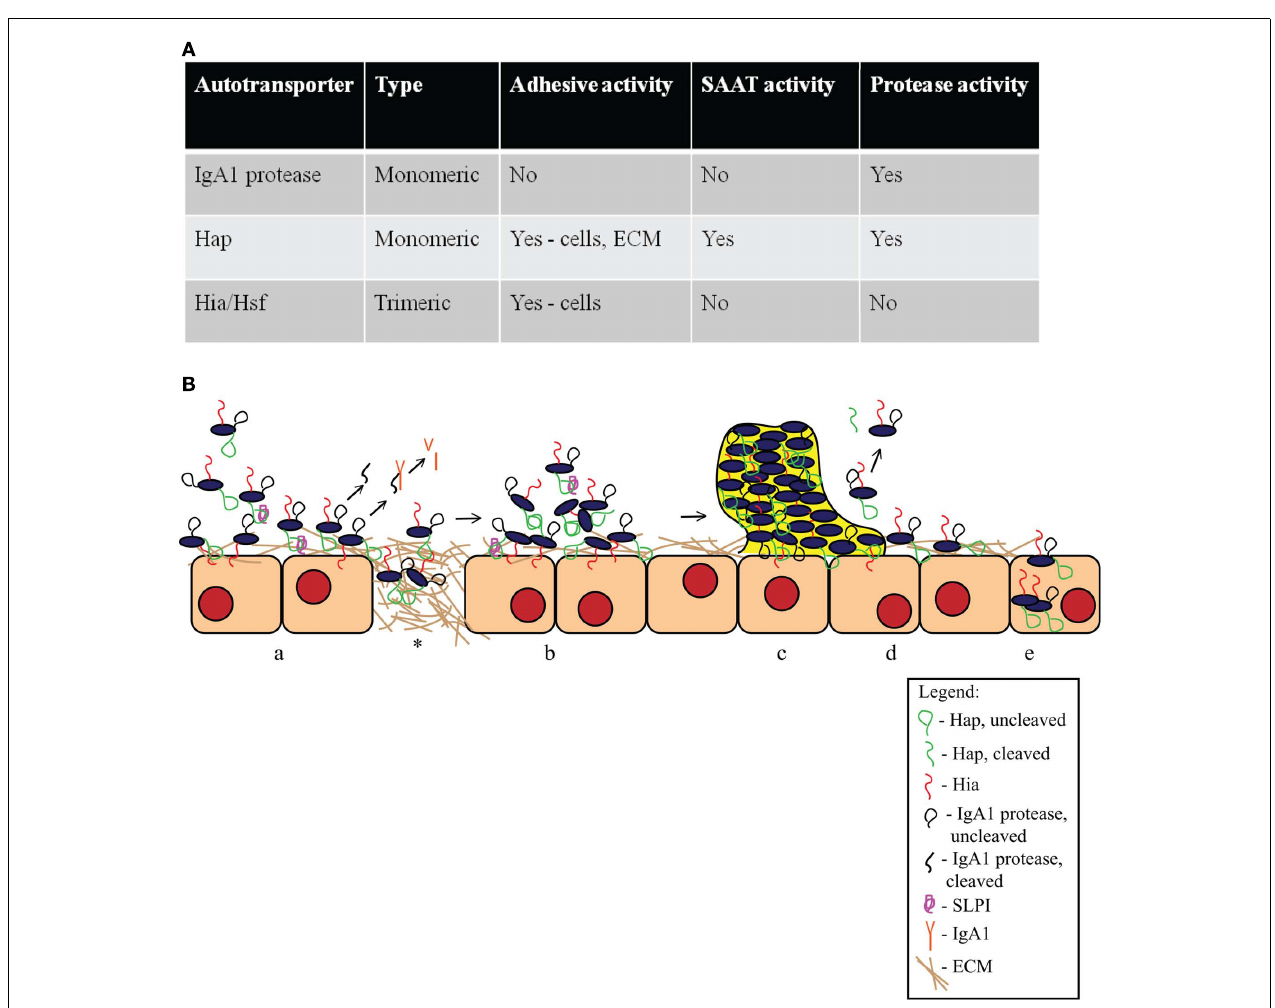
FIGURE 4 | Haemophilus influenzae autotransporter proteins. (A) Summary of key features of H. influenzae autotransporter proteins. (B) Schematic of the role of H. influenzae autotransporter proteins in the pathogenesis of disease. (a) Hap and Hia facilitate H. influenzae attachment to epithelial cells. Hap also promotes adherence to the ECM on the cell layer and at areas of damaged epithelium (*). Hap autoproteolysis is inhibited by SLPI, resulting in the retention of Hap s on the bacterial surface. IgA1 protease is released from the bacterial